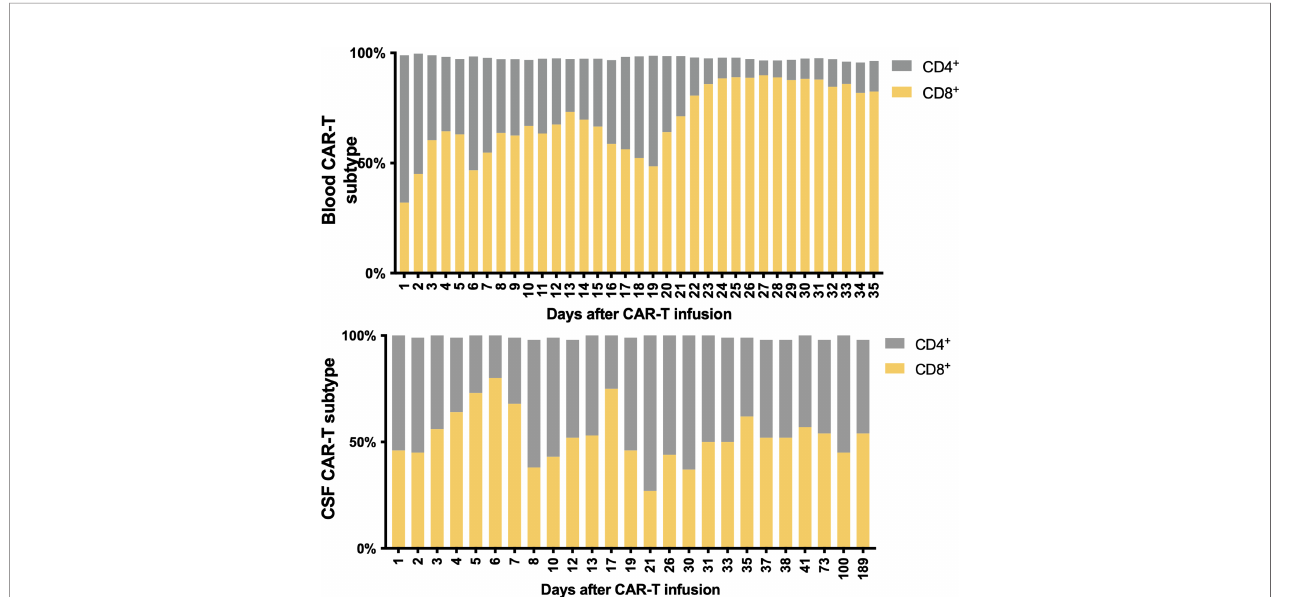
FIGURE 4 | Subtypes of CAR-T cells in peripheral blood and CSF. CD8 + cells were predominant in the PB after CAR-T therapy, while it returned to normal CSF proportions in 7 days.